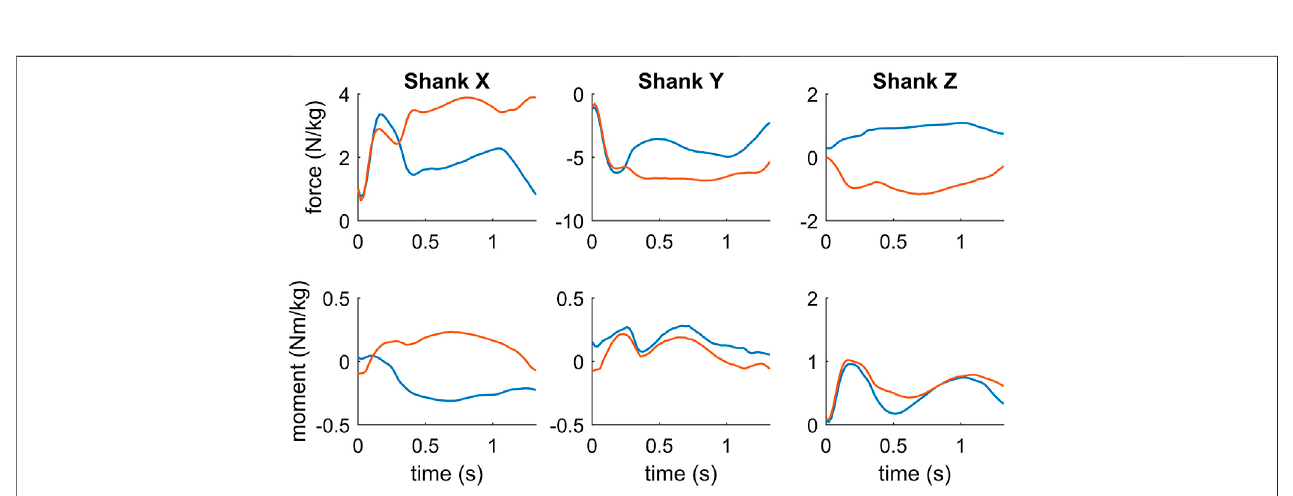
FIGURE6| Intersegmental forcesandmoments atkneejointoftheinsideleg (blue)andoutsideleg(red), respectively.Forcesandmomentsarerepresented inthe shank coordinate system, where the z -axis, x -axis and y -axis refer to the medial-lateral, anterior-posterior and superior-inferior direction. Positive joint moments denote an internal knee extension, adduction and internal rotation moment,